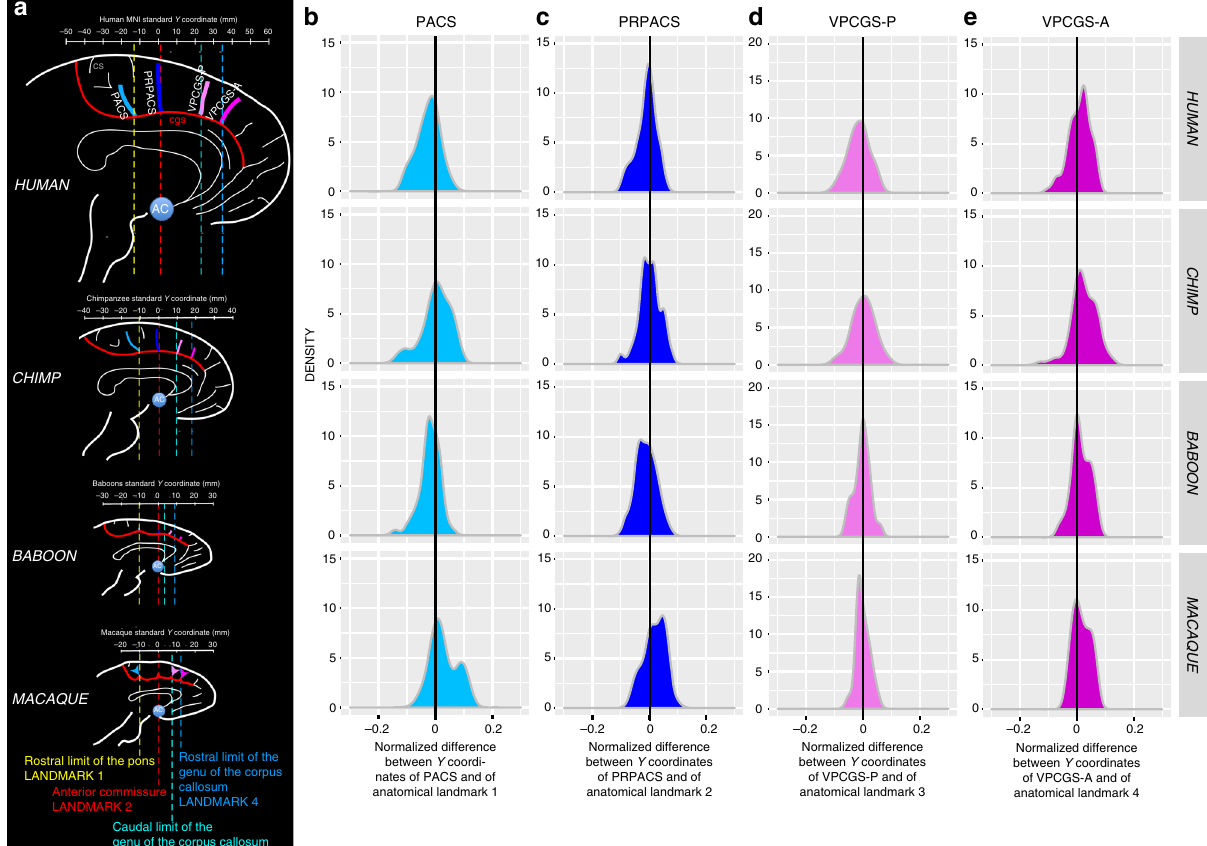
Fig. 3 Location of vertical sulci in the dorsal MFC across primates. a Schematic representation of the location of the various sulci in the respective standard space of each primate species. The scale represents the antero-posterior level (in mm) in each brain. Fixed anatomical landmarks across primates are displayed: the rostral limit of the pons (landmark 1, in yellow), the anterior commissure (landmark 2, in red), the caudal limit of the genu of the corpus callosum (landmark 3, in light blue), and the rostral limit of the genu of the corpus callosum (landmark 4, in dark blue). b Density of the difference between the Y coordinates of PACS and of the anatomical landmark 1 in human, chimpanzee, baboon, and macaque (from top to bottom panels). This difference was normalized in relation to the brain size (total antero-posterior extent). The 0 value corresponds to the Y level of the anatomical landmark 1 in standard brains. c Density of the normalized difference between the Y coordinates of PRPACS and of the anatomical landmark 2. The 0 value corresponds to the Y level of the anatomical landmark 2 in standard brains. d Density of the normalized difference between the Y coordinates of VPCGS-P and of the anatomical landmark 3. The 0 value corresponds to the Y level of the anatomical landmark 3 in standard brains. e Density of the normalized difference between the Y coordinates of VPCGS-A and of the anatomical landmark 4. The 0 value corresponds to the Y level of the anatomical landmark 4 in standard brains. Source data are provided as a Source Data fi